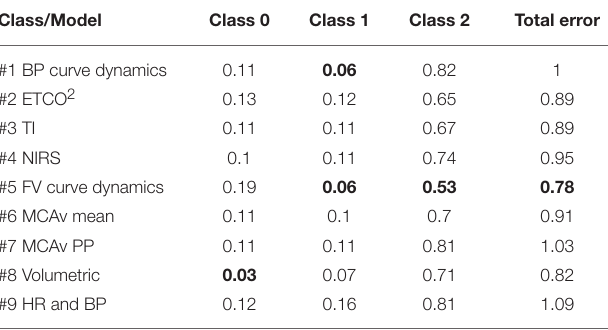
TABLE 4 | Median mean squared errors per model.